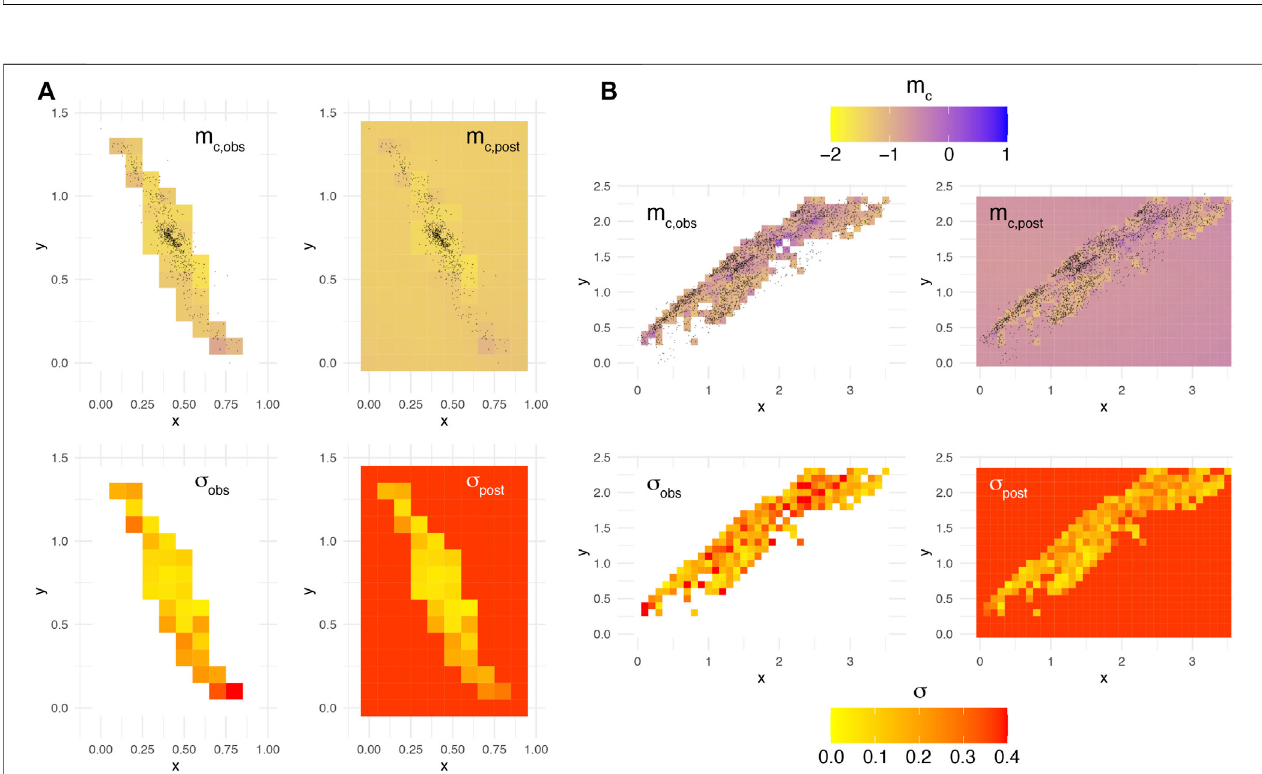
FIGURE 5 | Observed m c , obs vs. posterior m c , post maps derived from the BMC prior model. (A) S93 at depth z (cid:1) − 3 . 1 km (B) CB12 at depth z (cid:1) − 4 . 2 km.